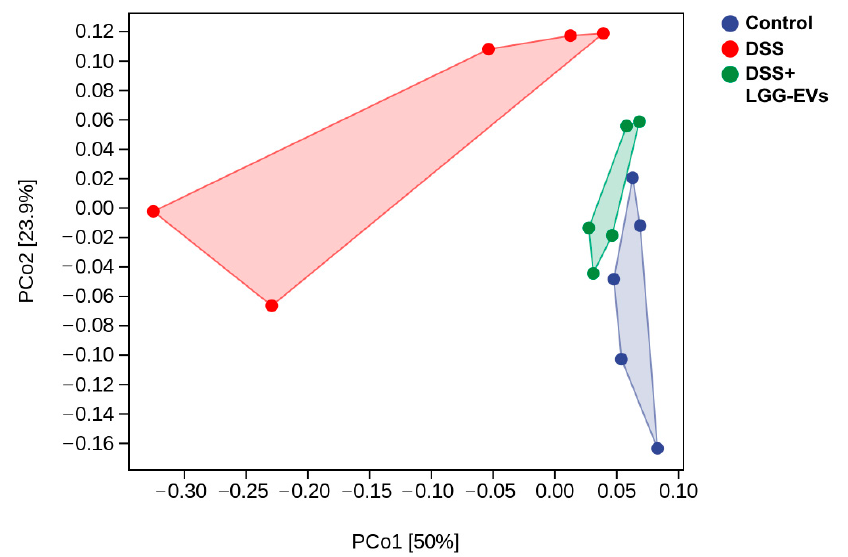
Figure 3. β -diversity evaluated using the weighted UniFrac-based PCoA (principal co-ordinates analysis) ( n = 5). Table 5. Alpha diversity indexes calculated with QIIME2 according to ASV/OTU numbers of each group. ( n = 5).